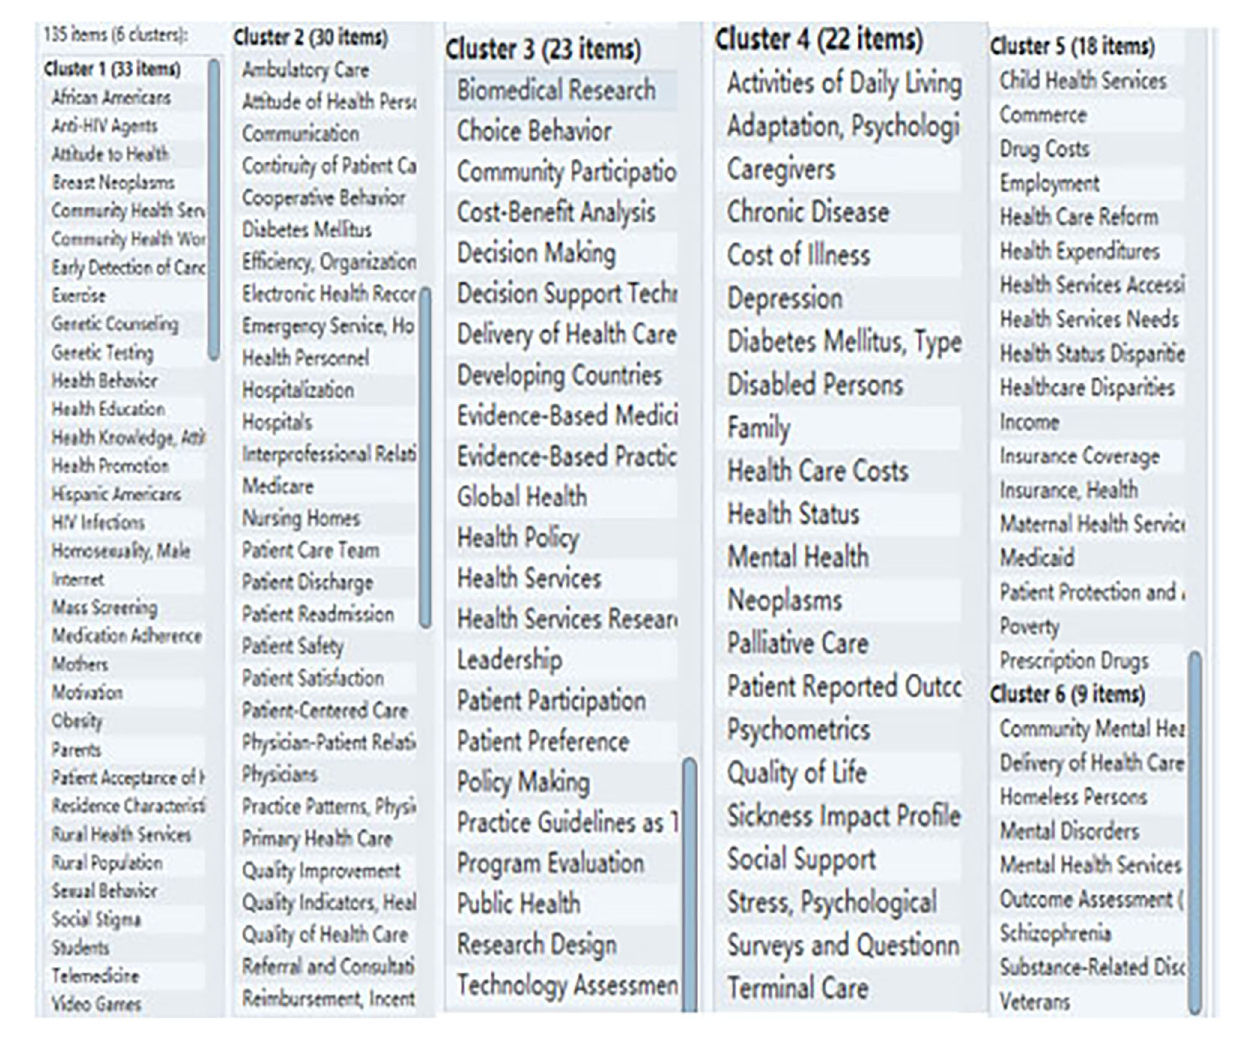
FIGURE 5 | Clustering analysis results of health policy and